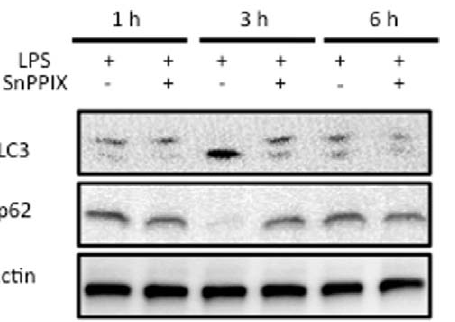
Figure 4. Effects of SnPPIX on autophagy during LPS treatment in the heart. Western blot analysis of the rat heart treated with LPS (15 mg/kg for 1, 3, and 6 h) with or without SnPPIX pretreatment (50 mg/kg, 24 h) to determine the levels of LC3-II and p62. Actin was detected as a loading control. Times indicated on the top of the panel show the treatment times for LPS.